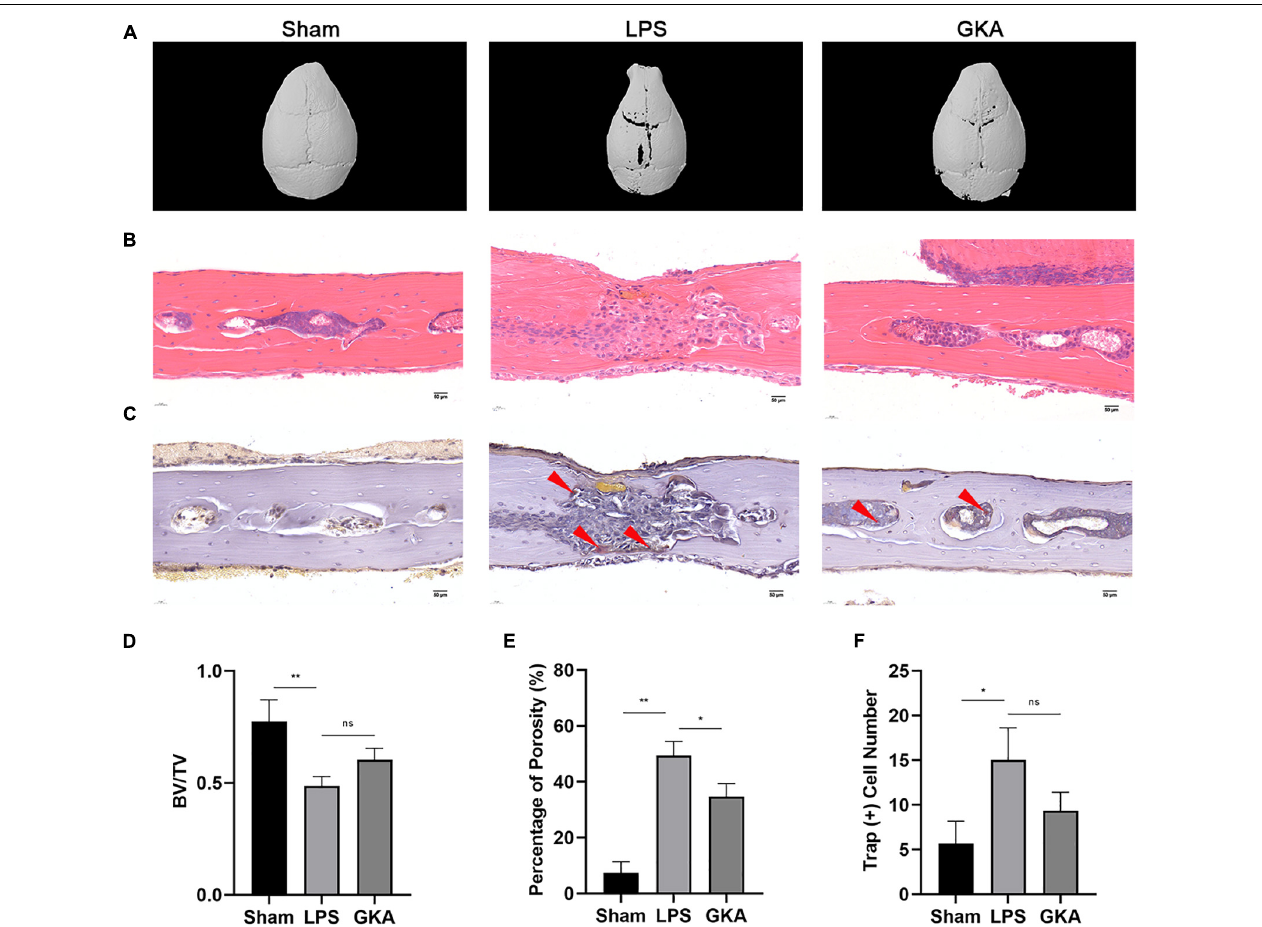
FIGURE 7 | GKA protects against LPS-induced inflammatory osteolysis of mouse calvarium in vivo. (A) Representative 3D micro-CT reconstructions of mouse calvarium from each group. (B,C) Representative hematoxylin-eosin staining (H&E) (100X magnification) and TRAP (100X magnification) stained sections from each group. (D–F) Quantitative analysis of (D) bone volume to total tissue volume (BV/TV), (E) percentage of porosity, and (F) the number of TRAP-positive cells were quantified. Values presented as the mean ± standard deviation ( n = 6); * p < 0.05, ** p < 0.01. ns, P > 0.05.